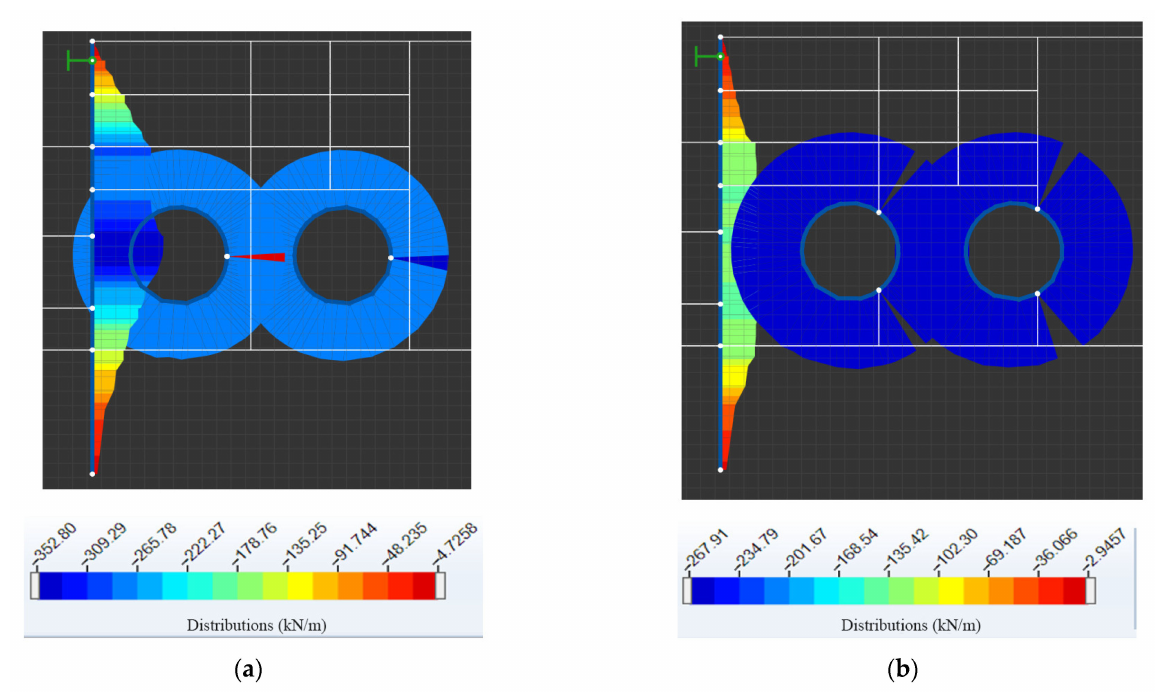
Figure 17. Axial force diagram under different horizontal distance L in stage (2): ( a ) L = 0.33 H and ( b ) L = 0.5 H.